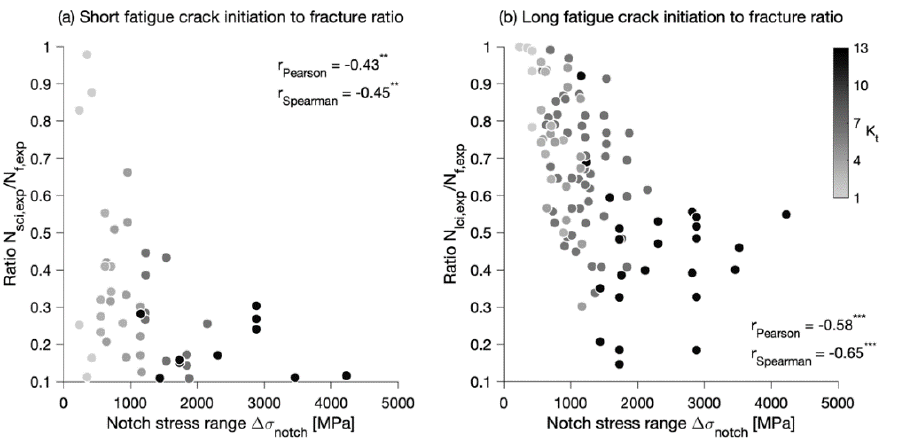
Figure 11. Comparison of ratios between ( a ) cycles until short or ( b ) long crack initiation with cycles to fracture (notch stress range mean stress corrected to R notch = to fracture (notch stress range mean stress corrected to R notch = 0).